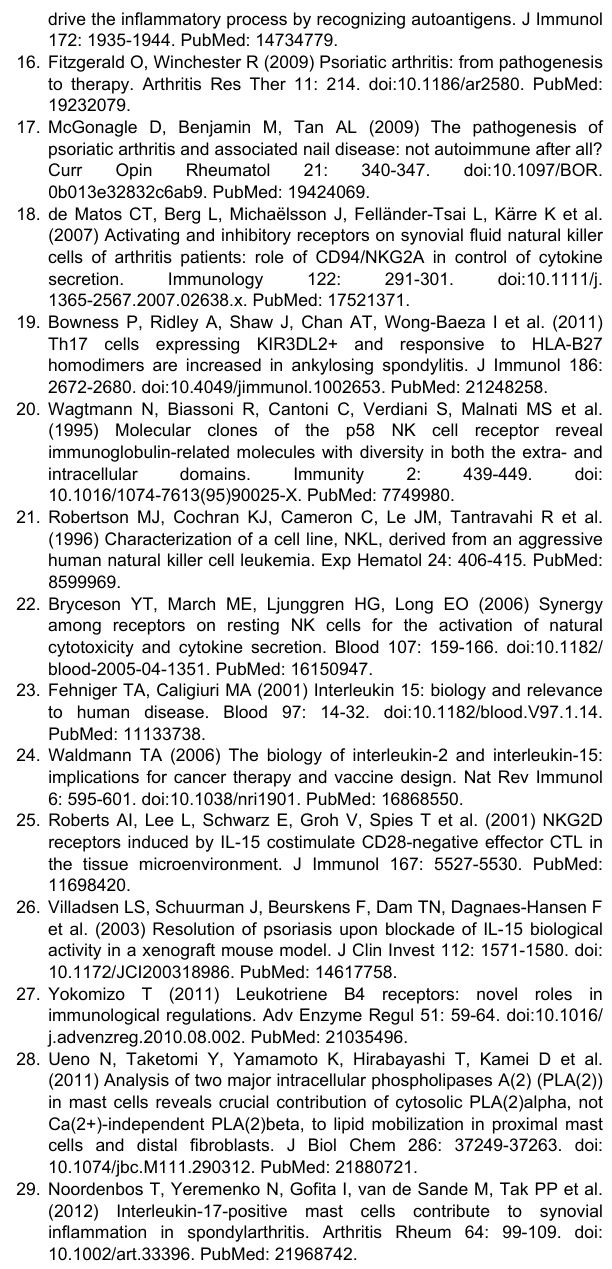
Figure S2. Joint fluid but not peripheral blood cells lyse MICA-expressing target cells efficiently. Lymphocytes from PsA patient joint fluid and blood were assessed for their ability to lyse MICA-expressing or control target cells. Addition of CF3 significantly impaired joint fluid cell cytolysis, while the addition of 100µM exogenous AA enabled peripheral blood cells to kill